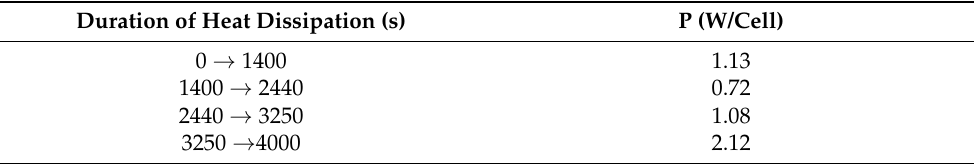
Table 5. Thermal load of the electric heaters during experiments for the highway driving cycle